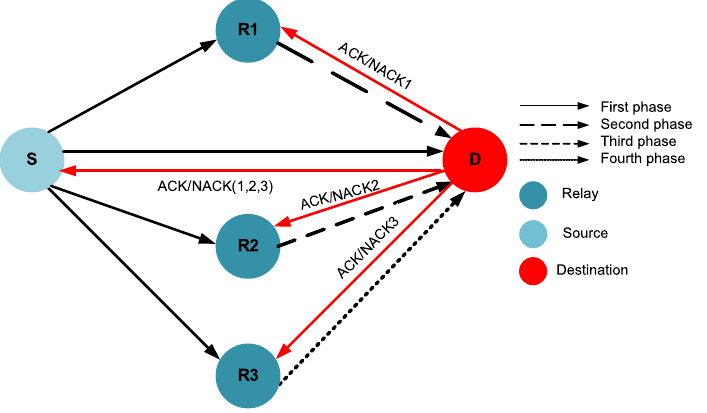
Figure 1. Three-stage incremental cooperative